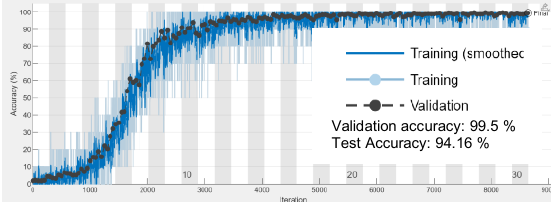
Fig. 14. Validation Accuracy of SqueezeNet